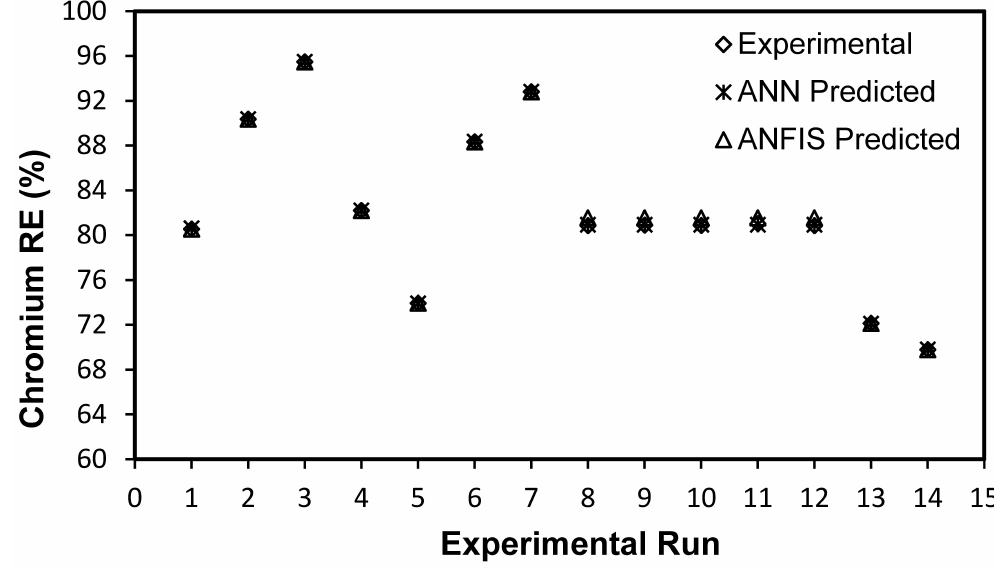
Figure 5. Experimental and predicted chromium (Cr) removal efficiencies of ANN and ANFIS models for the training dataset.